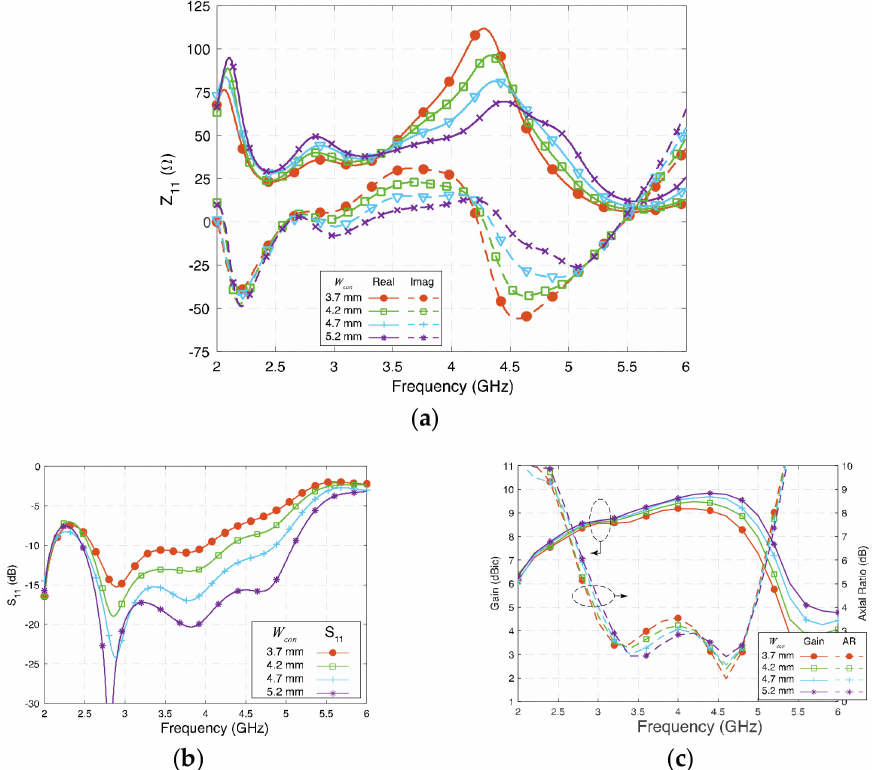
Figure 6. ( a ) Impedance (Z 11 ), ( b ) reflection coefficient (S 11 ), and ( c ) gain and axial ratio of the proposed antenna at different W con